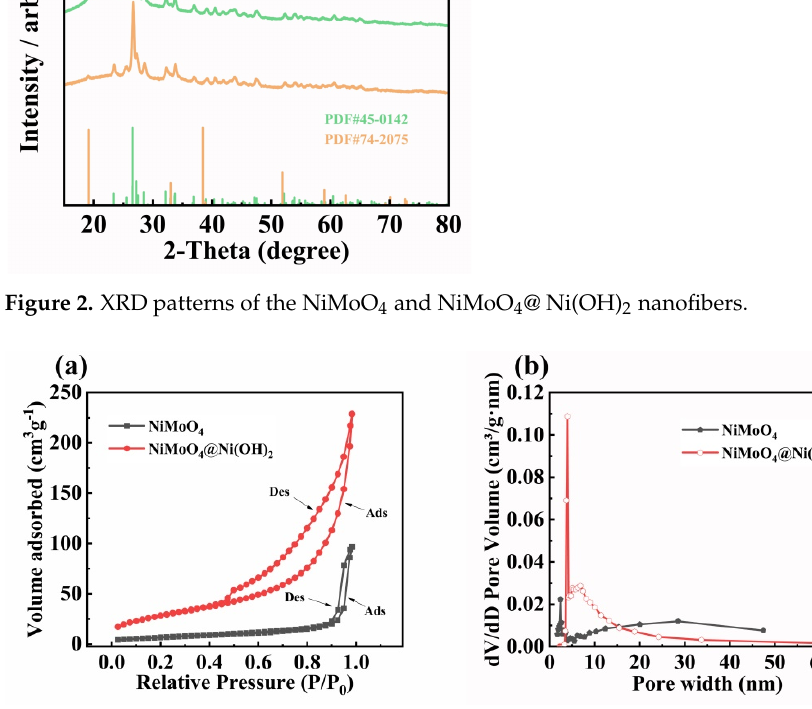
Figure 3. ( a ) N 2 adsorption–desorption isotherms and corresponding ( b ) pore size distribution curves of the NMO and NMH − 2.